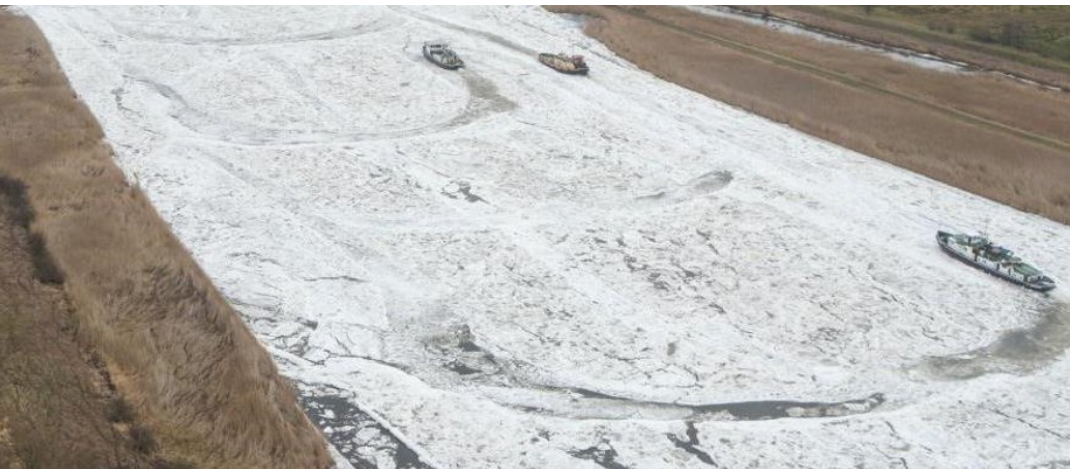
Figure 3. Ice breakers driving in loops to break up large sheets of ice cover (courtesy of Regional Water Management Authority, Szczecin).